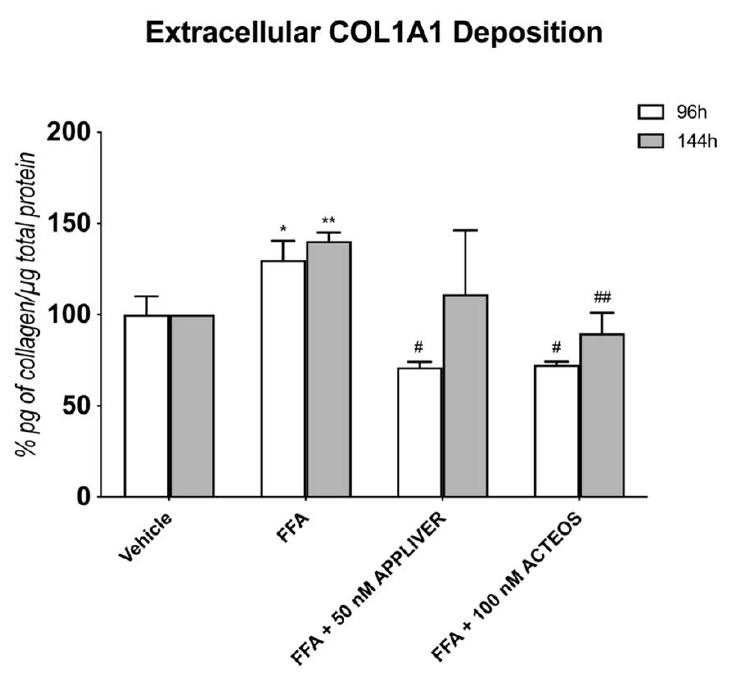
Figure 7. Quantification of extracellular COL1A1 deposition (% pg of collagen/ µ g total protein) using ELISA upon treatment with either APPLIVER or ACTEOS ± FFA after 96 h and 144 h. COL1A1 deposition was normalized to the total proteins in the cell lysate and reported as percentage vs. vehicle. Values presented are the mean ± SD of three independent experiments. * p < 0.05 vs. vehicle, ** p < 0.001 vs. vehicle, # p < 0.05 vs. FFA, ## p < 0.01 vs. FFA. Abbreviations: COL1A1, collagen type I alpha 1 chain; FFA, free fatty acids.